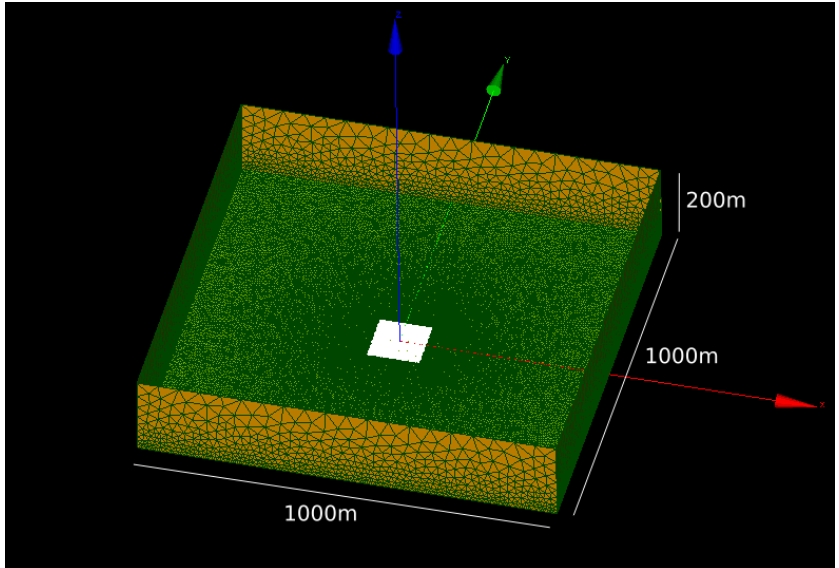
Figure 2. Meshed computational